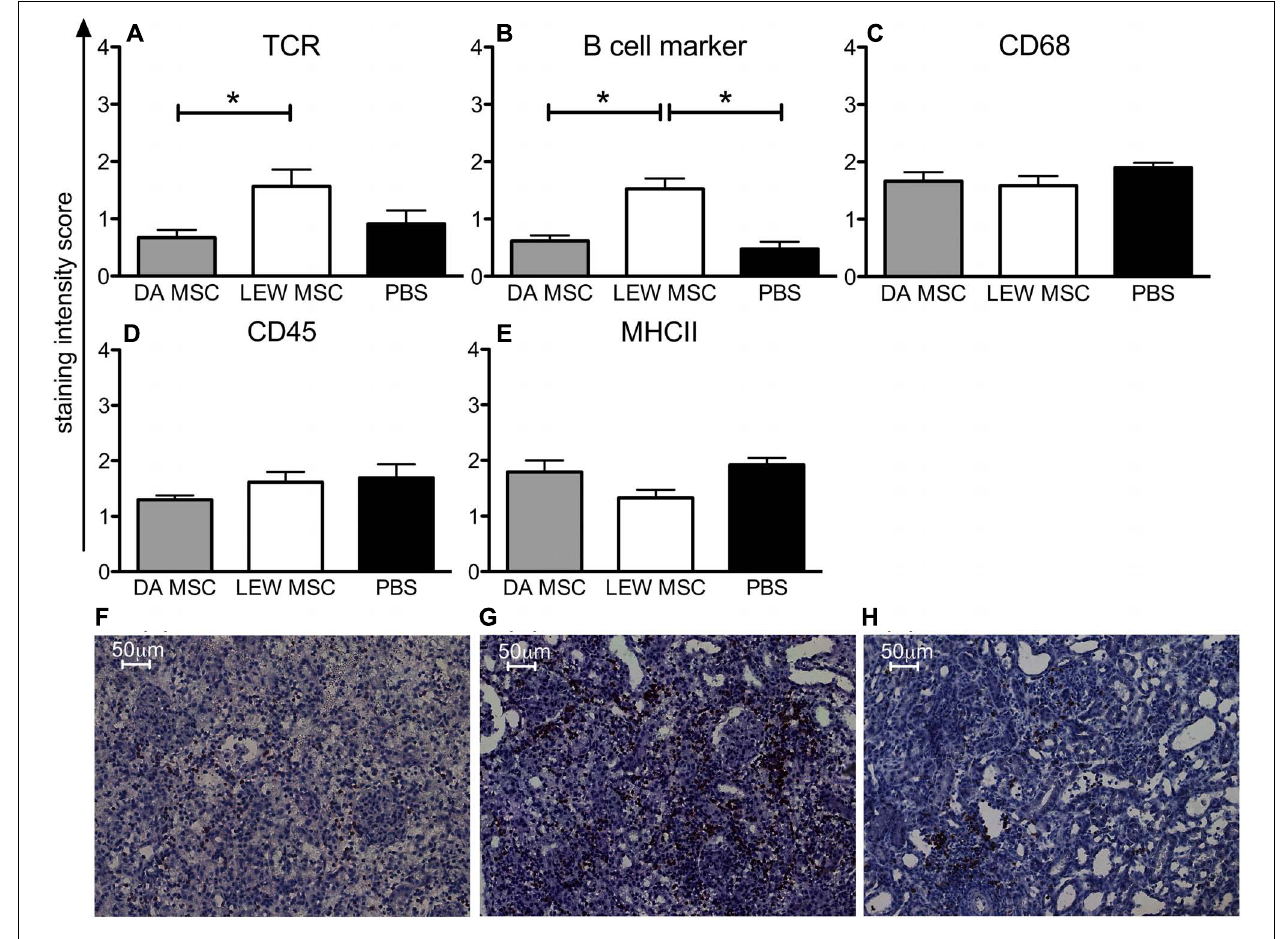
FIGURE 5 | Enhanced intragraft accumulation of T and B cells following MSC pre-treatment measured by immunohistology. Five to eight micron thick sections of transplanted kidneys were labeled with specific monoclonal mouse anti-rat antibodies to (A) TCR, (B) B cell marker, (C) CD68, (D) CD45, and (E) MHCII overnight at 4 ◦ C. A biotin-conjugated secondary antibody and streptavidin/HRP were